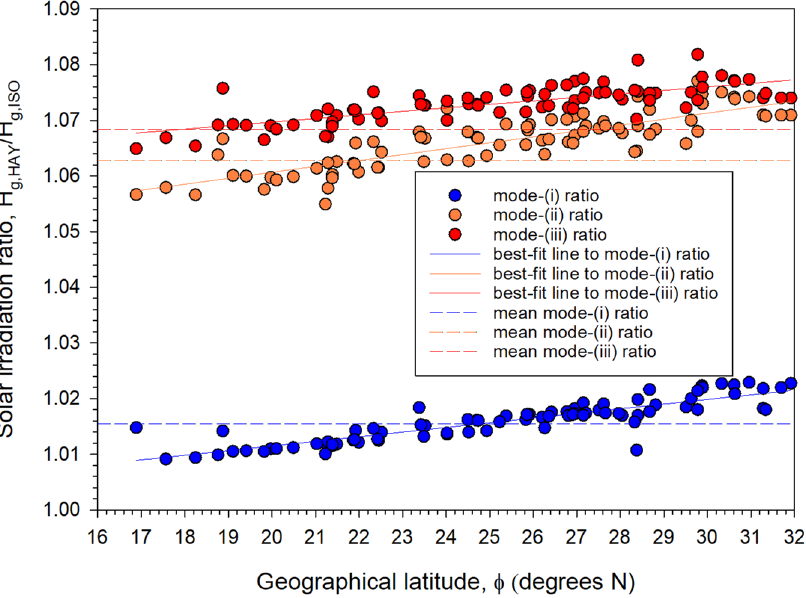
Figure 5. Annual solar energy yield ratios, H g,HAY /H g,ISO , for the 82 sites in Saudi Arabia averaged over the period 2005–2016 as function of the geographical latitude of the site, φ , under all-sky con- ditions. The data are shown for the 3 solar system configuration modes and both ISO- and HAY- modelled results. The best-fit lines have the following expressions: configuration mode-(i), H g, β S,HAY /H g, β S,ISO = 0.9948 + 0.0008 φ with R 2 = 0.78; configuration mode-(ii), H g, β t,HAY /H g, β t,ISO = 1.0394 + 0.0011 φ with R 2 = 0.70; and configuration mode-(iii), H g,t,HAY /H g,t,ISO = 1.0571 + 0.0006 φ with R 2 = 0.56.